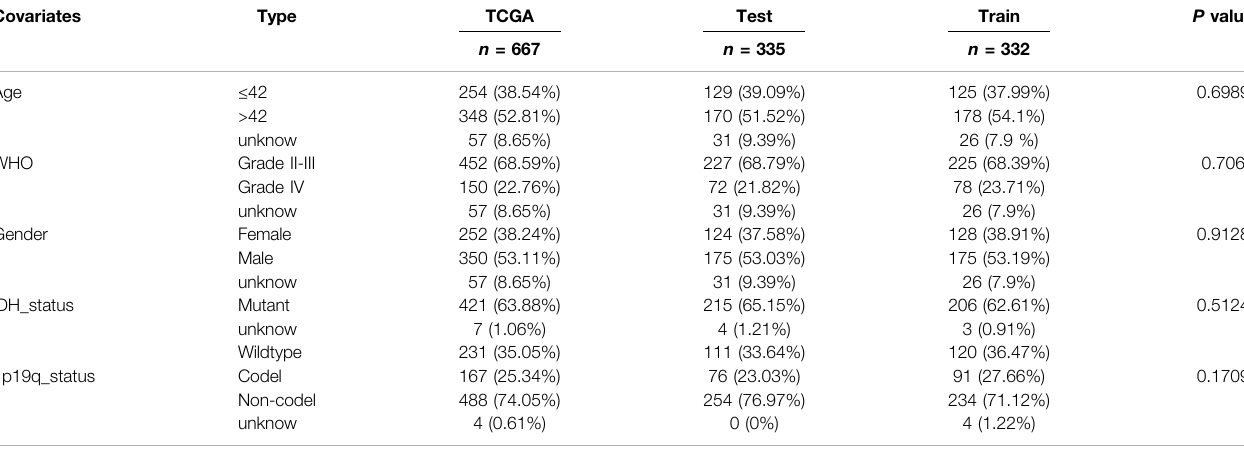
TABLE 1 | Clinical information for three Glioma patients groups in this study. Covariates